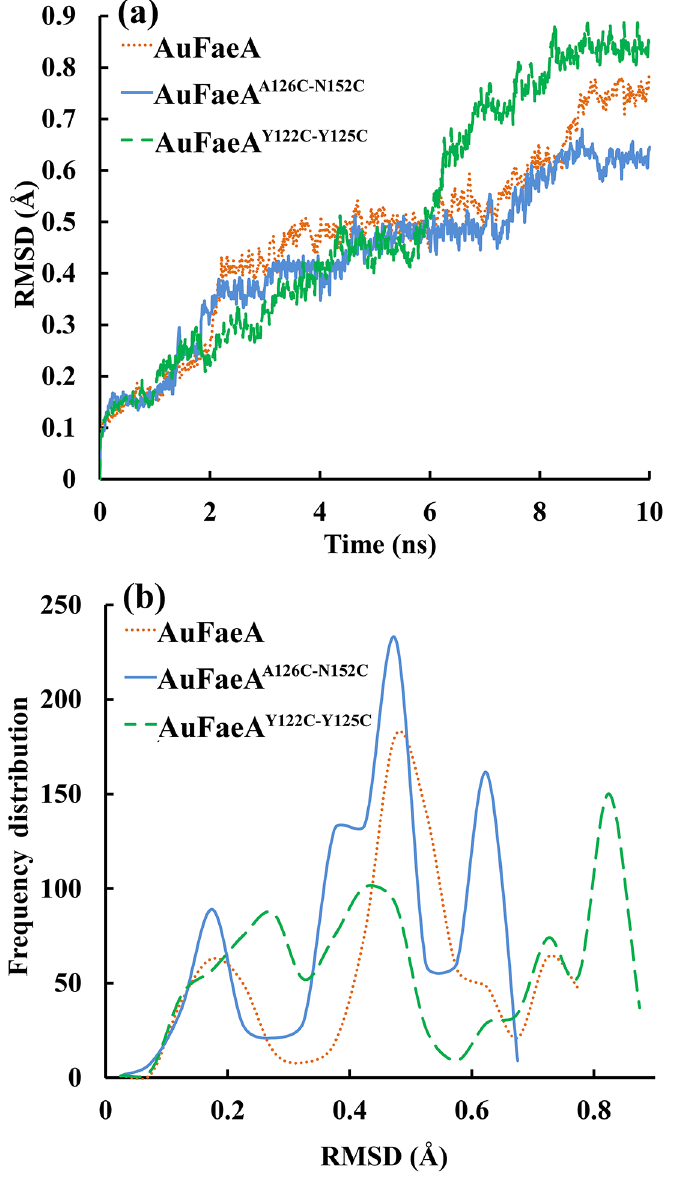
Fig 3. Calculation and distribution of the RMSD values. Graphical representation of: (a) RMSD values of AuFaeA (dotted line), AuFaeA A126C-N152C (solid line), and AuFaeA Y122C-Y125C (dashed line), respectively, after MD simulation processes at 500 K for 10 ns. (b) Distribution of RMSD values of AuFaeA (dotted line), AuFaeA A126C-N152C (solid line), and AuFaeA Y122C-Y125C (dashed line). MD, molecular dynamics; RMSD, root mean square